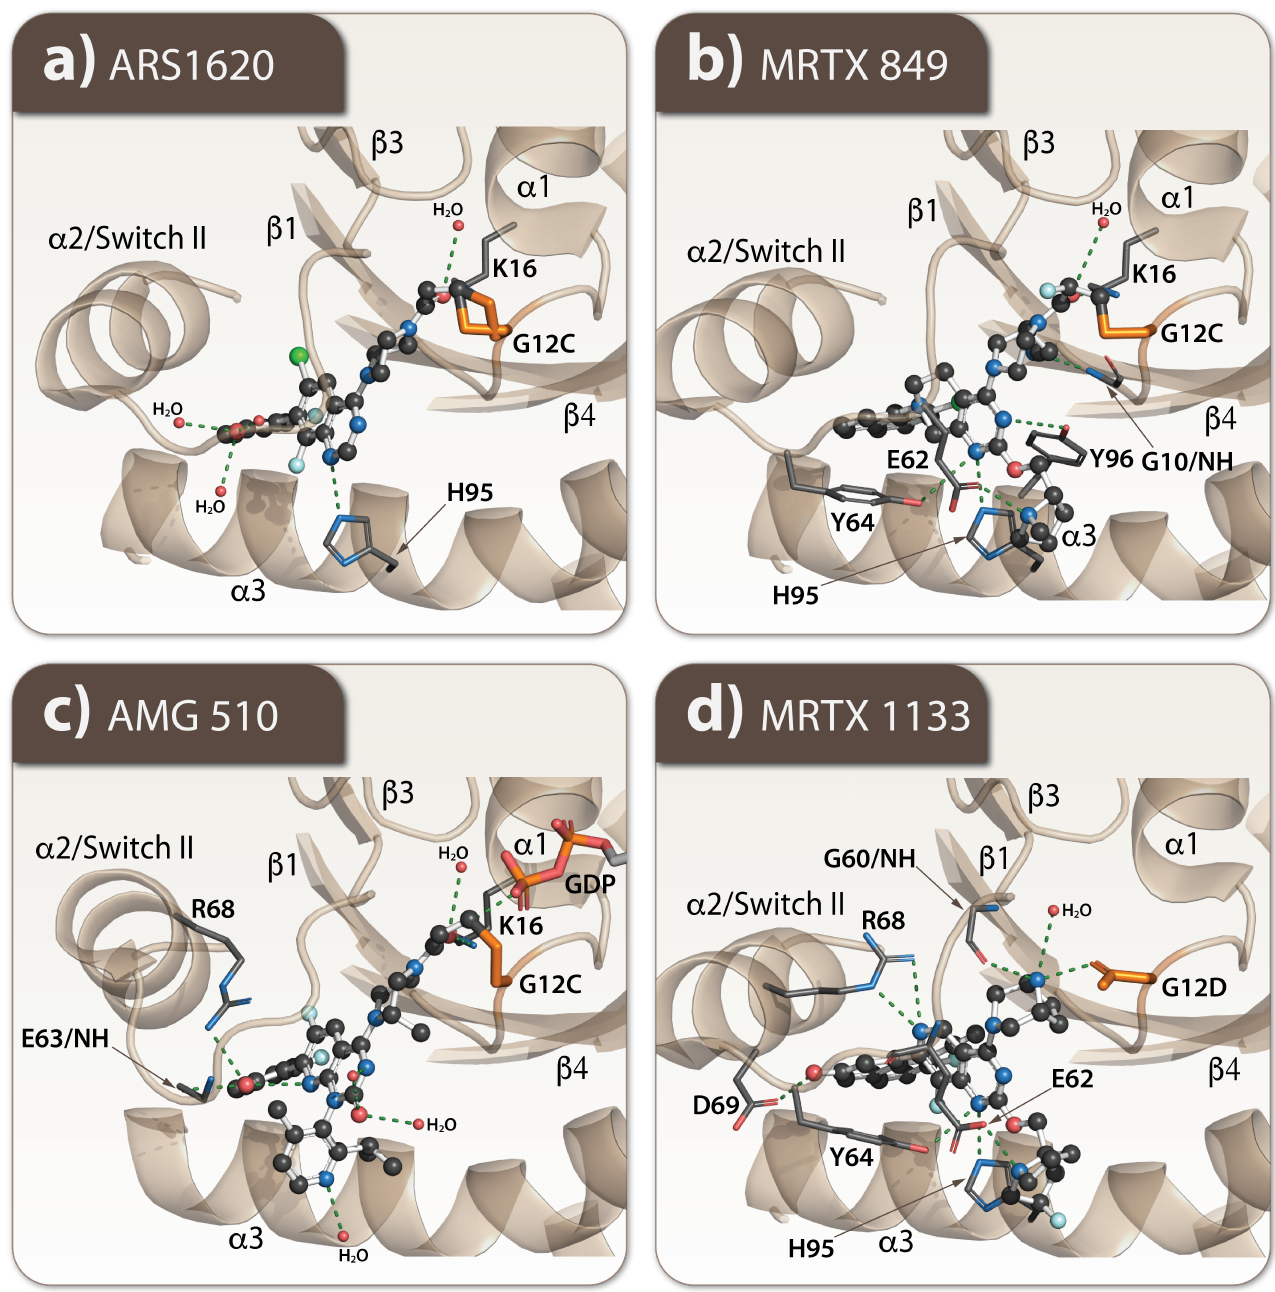
Figure 4. Mechanism of interaction of RAS inhibitors. The molecular interaction of selected inhibitors is shown. All the three G12C mutants have covalently bound ligands compared to G12D, which instead forms an H-bond with its D12. Moreover, all ligand-bound G12C mutants use K16 as a contact point; its position is well-conserved in all three structures. In the G12D structure, this interaction is missing. ( a ) ARS 1620 (PBDID 5V9U) interacts with K16 and H95 and uses three water-mediated contacts. ( b ) MRTX 849 (PBDID 5F2E) besides K16 and H95 also interacts with E62, Y64, and Y96, the backbone of G10, and one water molecule. In addition, it interacts with the GDP molecule that may prevent its exchange to GTP. ( c ) AMG 510 interacts with K16, backbone of E63, R68 from Switch II, and creates three water-mediated contacts. ( d ) MRTX 1133 also interacts with R68 from Switch II, D69, Y64, H95, E62, and the backbone of G60 and forms one water-mediated